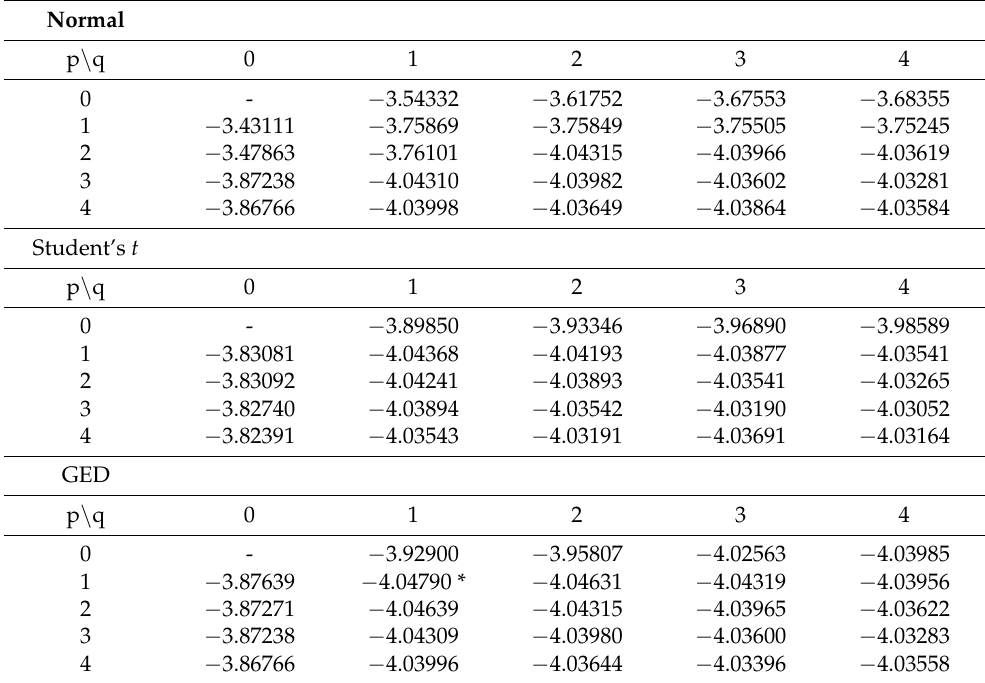
Table 2. Bayesian information criterion for different GARCH(p,q) using normal, Student’s t and generalized error distribution (GED). The model that minimizes the BIC is the GARCH(1,1) using GED and the matching BIC statistic is marked with an asterisk.